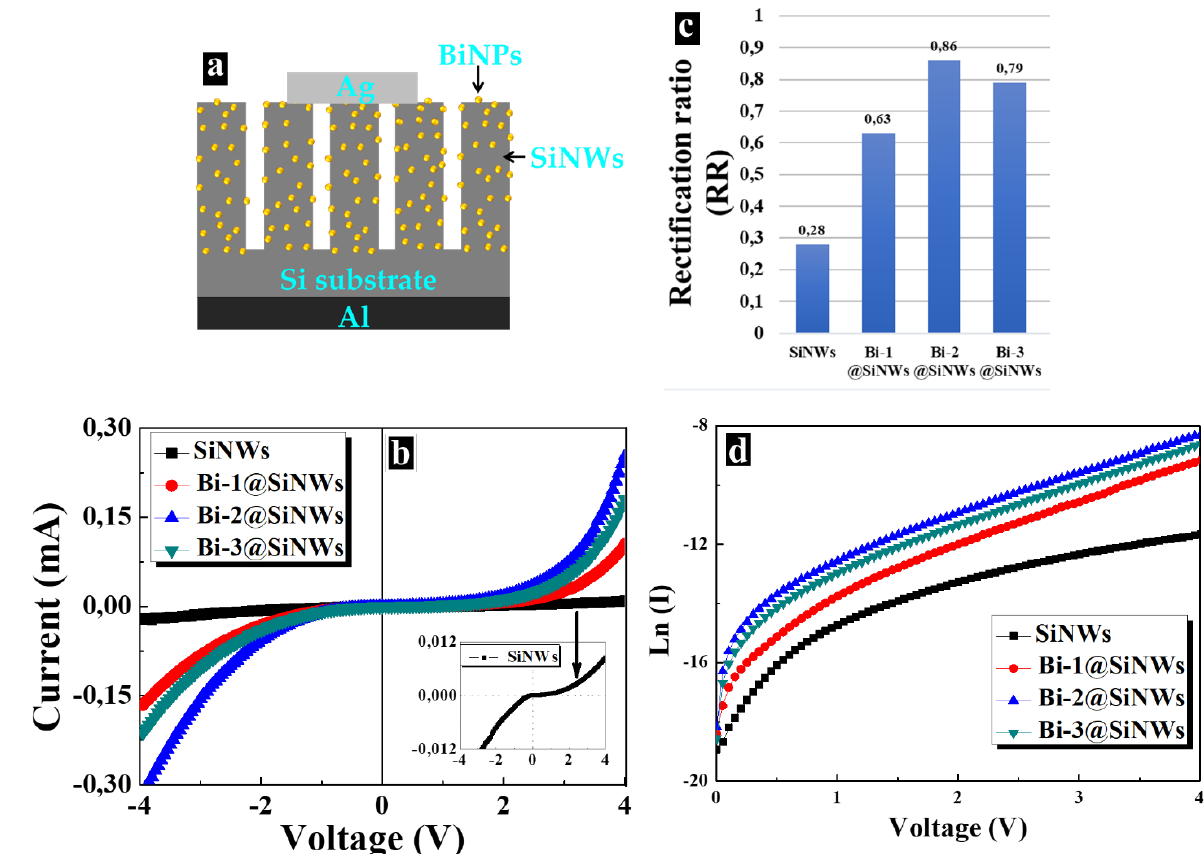
Figure 4. ( a ) Schematic illustration of the Ag/Bi@SiNWs-Si/Al device. ( b ) I – V characteristics of the prepared device at different Bi thicknesses compared to a Bi-free device. The inset displays the en- larged I – V curves of the Bi-free device. ( c ) Comparison of the devices rectification ratio (RR). ( d ) Ln (I) vs. V curves of the prepared devices. ( d ) Ln (I) vs. V curves of the prepared